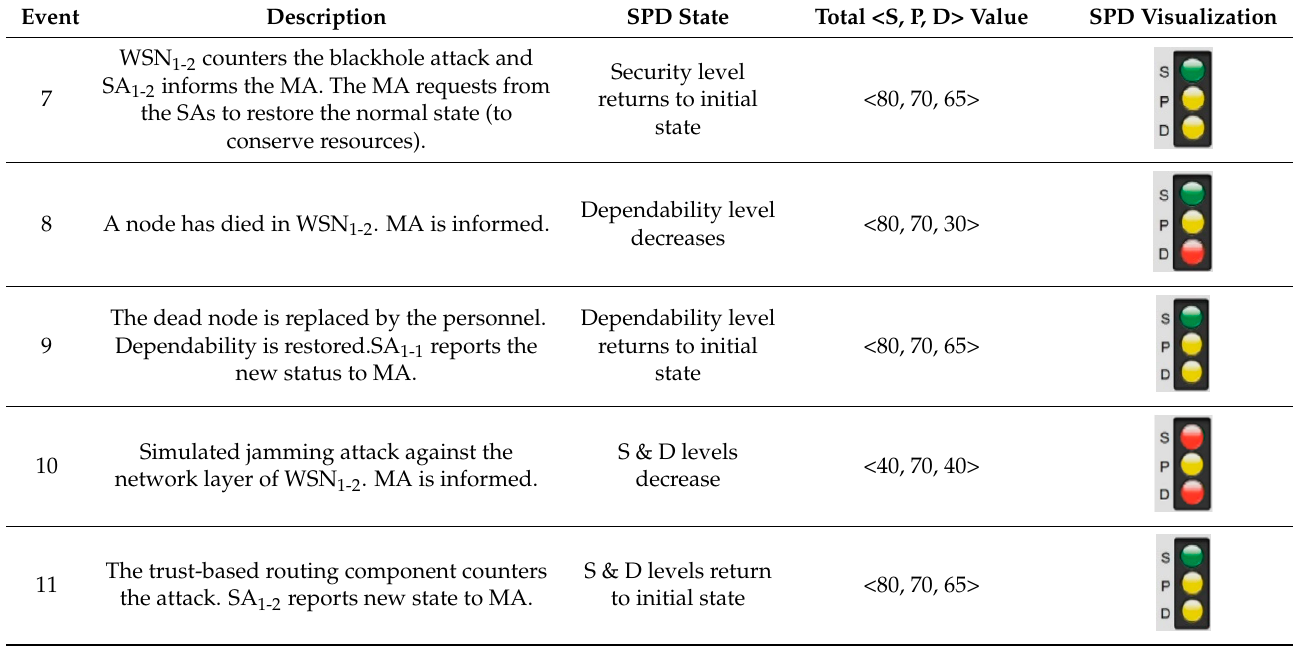
are installed in the edge